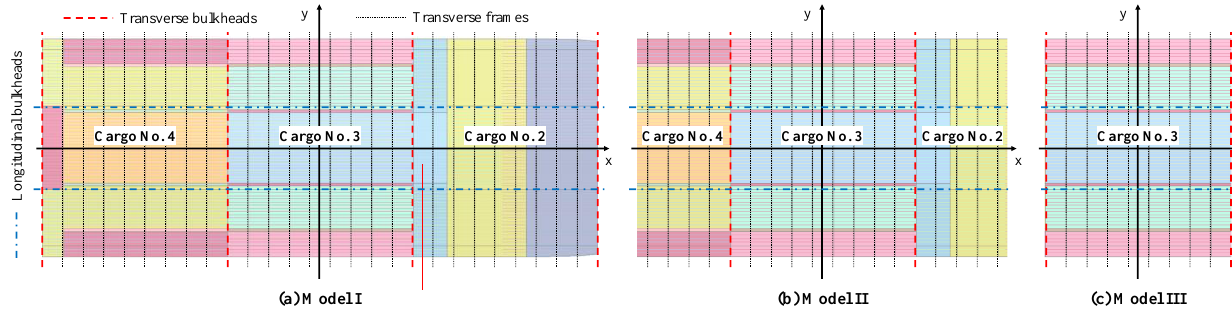
Figure 4. Three kinds of extent of the analysis. Figure 5 presents the effects of boundary conditions and extents of analysis on struc- tural behavior considering the reference scenario in Section 4. It shows that structural re- sponses (penetration, absorbed energy and resultant force) were slightly larger with the smaller extent of analysis, but the differences were minor. On the other hand, the wider models (Model I) gave larger frictional energy than the other models because Model I was more flexible. Table 3 summarizes the maximum structural response.